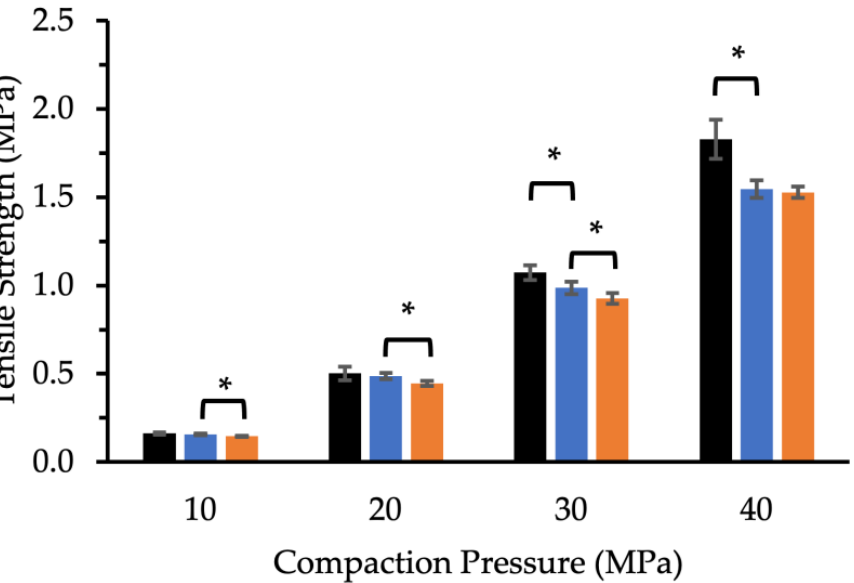
Figure 2. Tensile strength values ( n = 5) of control tablets ( (cid:4) ) and MUPS tablets compacted at various compaction pressures containing MCC ( (cid:4) ) or XPVP pellets ( (cid:4) ). Error bars indicate the standard deviation and * denotes a significant ( p < 0.05) difference.